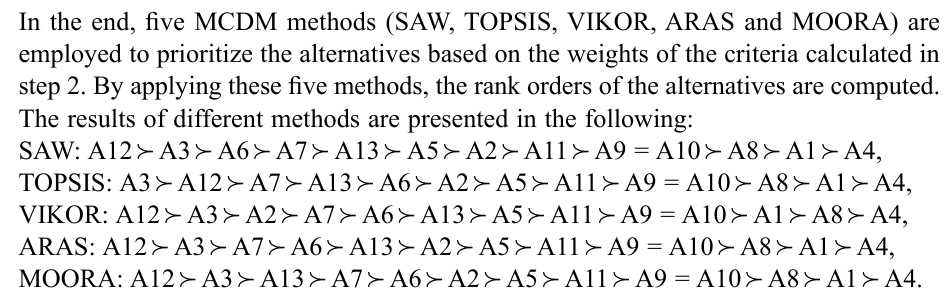
Table 11 shows the ranking orders of six methods. Table 11. Rankings resulted by different methods Method TOPSIS VIKOR SAW MOORA ARAS